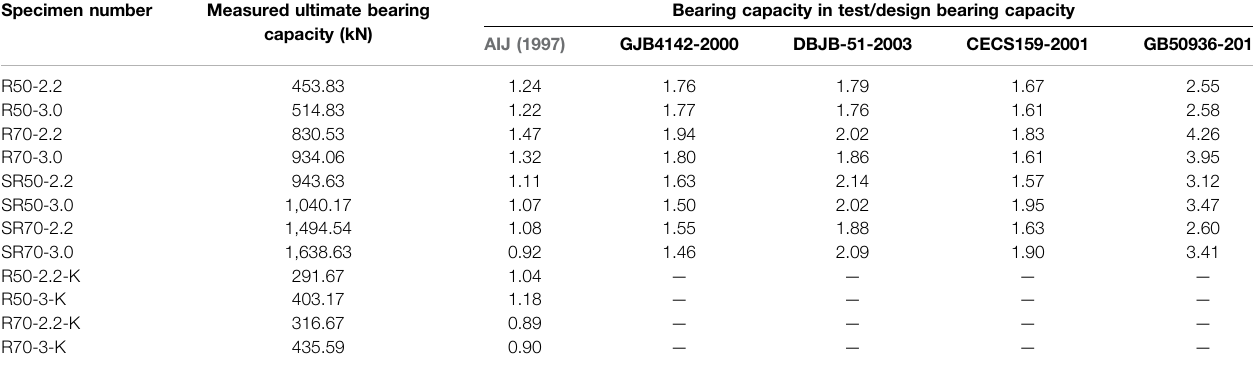
TABLE 2 | Comparison of calculated bearing capacity. Specimen number